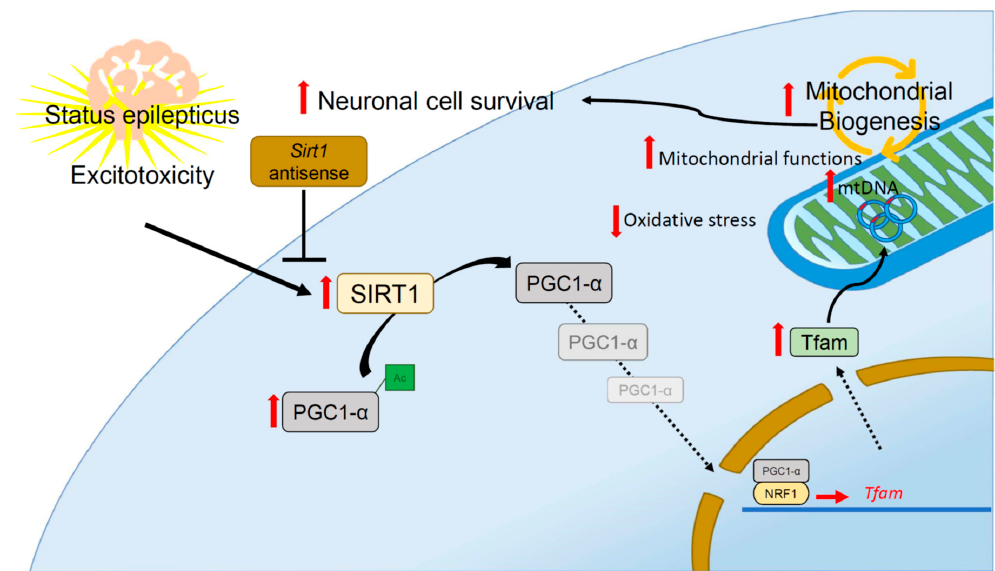
Figure 6. Schematic diagram illustrating the proposed SIRT1 signaling pathway involved in PGC1 α / mitochondrial biogenesis that exerted an endogenous protective mechanism in the hippocampal neuronal tissue following experimental status epilepticus. Excitotoxicity induced by experimental status epilepticus may activate SIRT1 expression that can lead to the deacetylation (Ac) of PGC-1 α by SIRT1 and induce mitochondrial biogenesis machinery expression in hippocampal neuronal cells. Downregulation of SIRT1 by Sirt1 gene knockdown decreased mitochondrial biogenesis machinery expression, which was accompanied by impaired mitochondrial respiratory function, increased protein oxidation, and raised the apoptotic process and neuronal